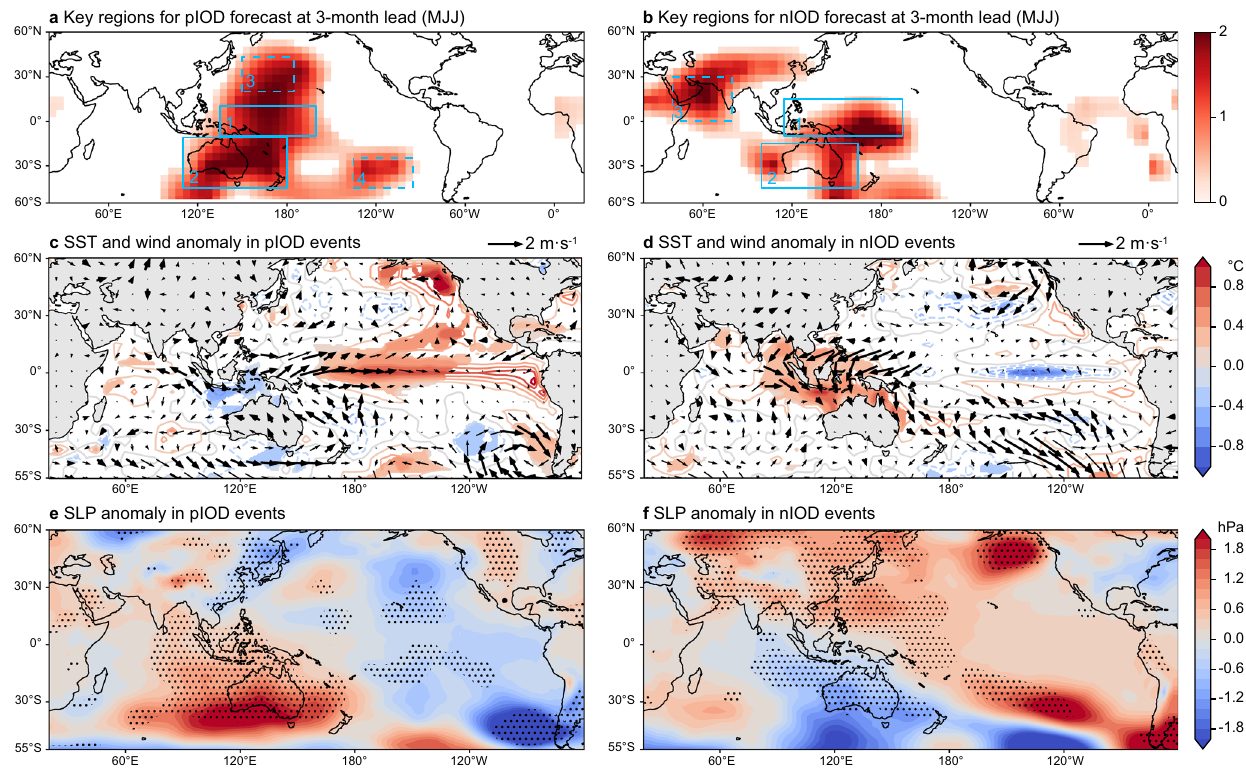
Fig. 3 | Physical interpretation ofthe Indian Ocean Dipole (IOD) predictions at 3-monthlead.a Spatialattentionmapofthe fi vestrongpositiveIODevents(pIOD) during 1983 – 2019 based on the 3-month lead predictions, i.e., initiated from May- June-July (MJJ). Only the values statistically signi fi cant at 10% level are displayed. The heatmap values are split into different key regions (i.e., blue boxes) according to known physics. The composite maps of ( c ) sea surface temperature (SST;